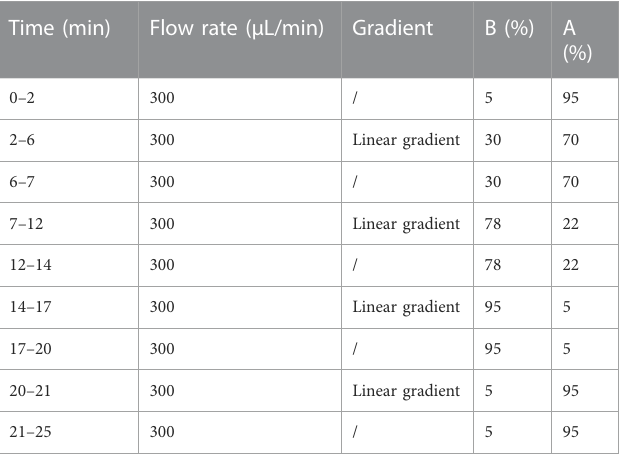
TABLE 1 Liquid chromatography mobile phase